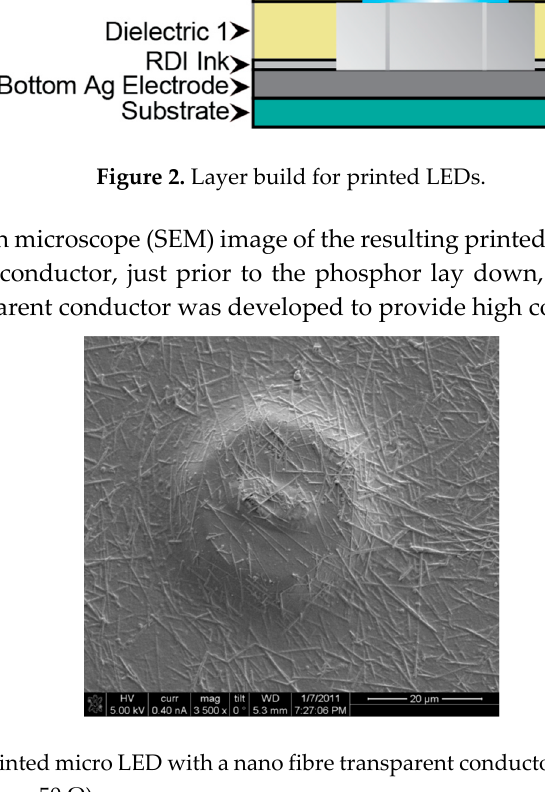
Figure 3. SEM of a printed micro LED with a nano fibre transparent conductor (one-shot transmission T = ~97%, and resistance 50 Ω